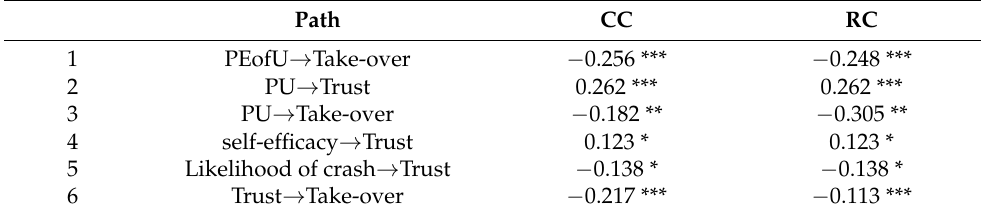
Table 13. Table of standardized path analysis